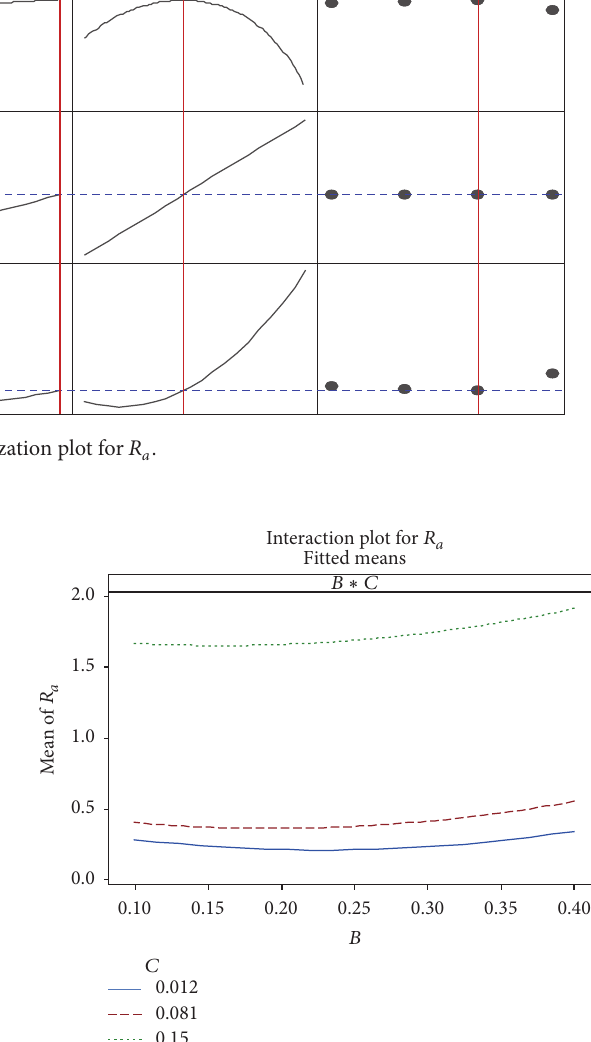
Figure 6: Interaction plot of depth of cut and feed rate for 𝑅 𝑎